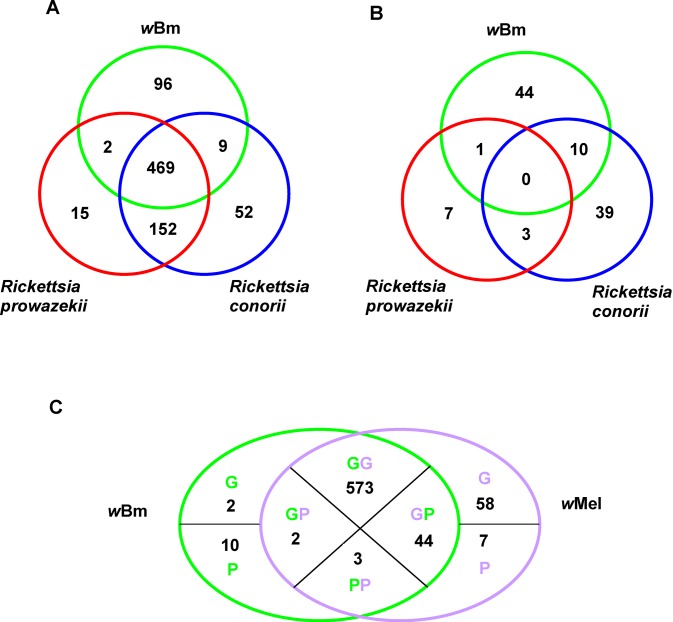
Venn Diagram Showing Comparison of Conserved and Unique Genes and Pseudogenes in wBm (Wolbachia from B. malayi), Rickettsia prowazekii, Rickettsia conorii, and in wBm and wMel (among Those Assigned to COGs)(A) Predicted functional protein-coding genes.(B) Pseudogenes.(C) Combined results for comparison between wBm and wMel.G, intact gene; P, pseudogene.